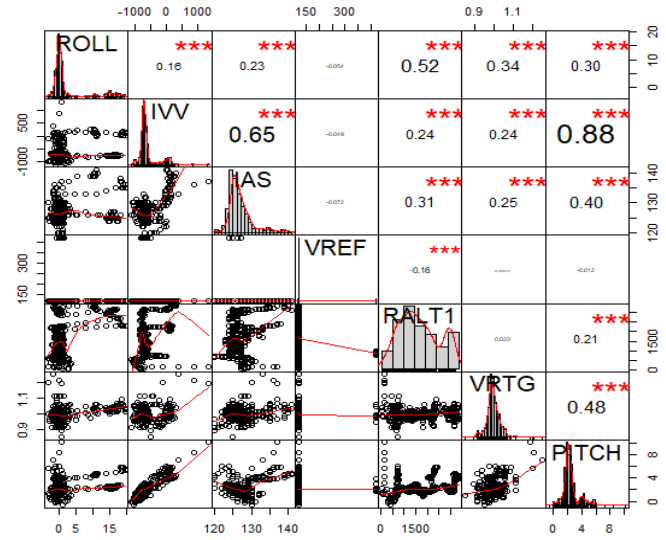
Figure 4. Schematic representation of factor correlation. “***” means the corresponding correlation coe ffi cient is significant at a level close to